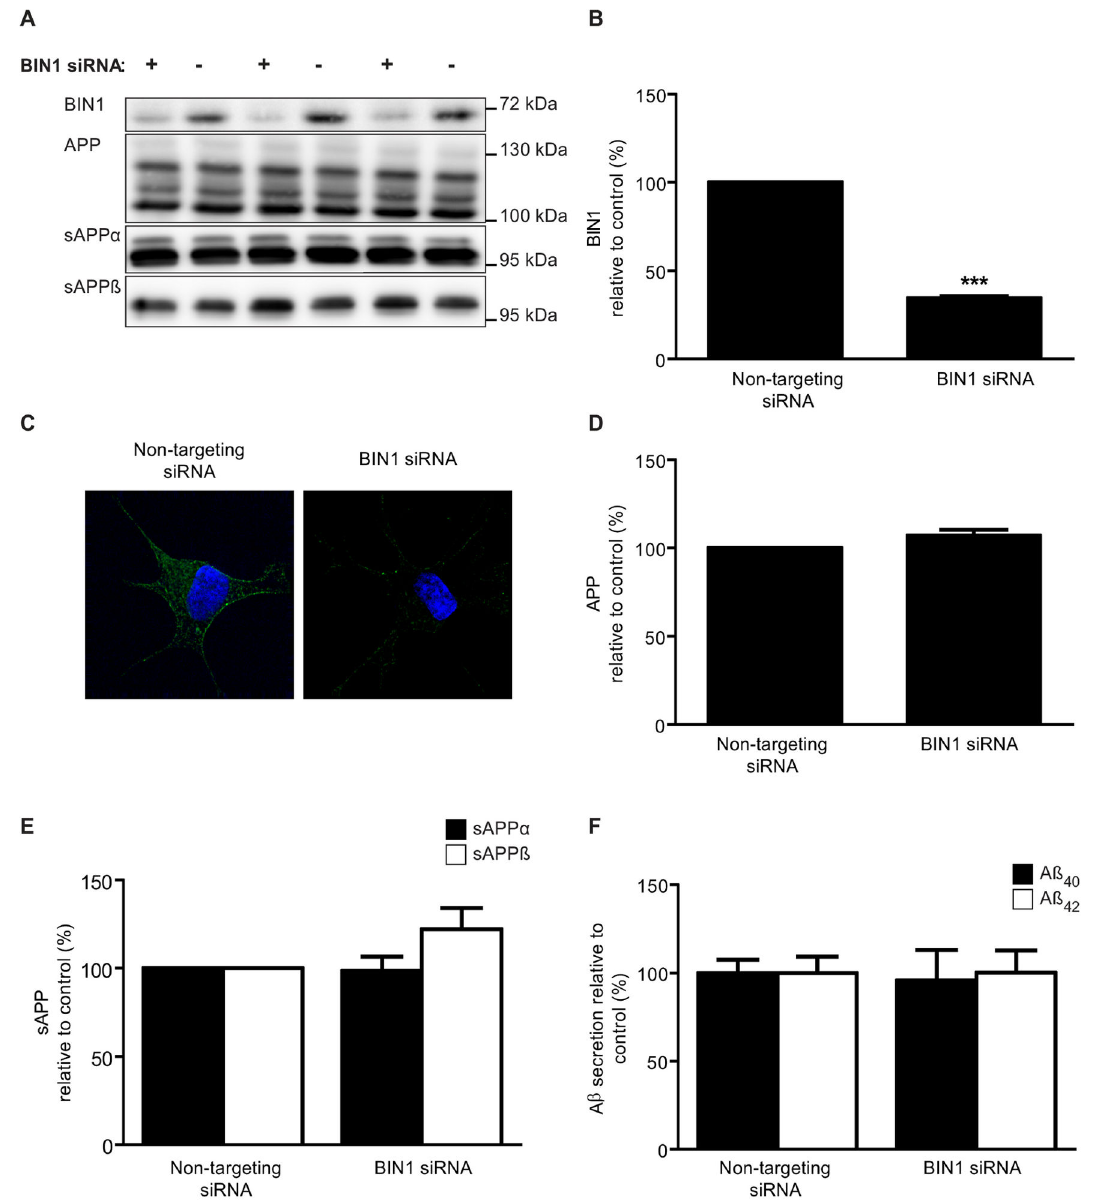
Figure 4. BIN1 knockdown has no effect on APP processing. SH-SY5Y cells were transfected with either siRNA against BIN1 (+) or non-targeting control siRNA (-). Representative immunoblots of cell lysates (BIN1 and APP) and conditioned media samples (sAPPα and sAPPβ) (A). Fluorescence microscopy images of BIN1 (green) and DAPI staining (blue) (C). Densitometric analysis of BIN1 (B), APP (D) and sAPPα and sAPPβ (E) relative to total protein. ELISA analysis of Aβ40 and Aβ42 in conditioned media (F). Data represent mean ± S.D., n=3, *p<0.05, Independent T-test.